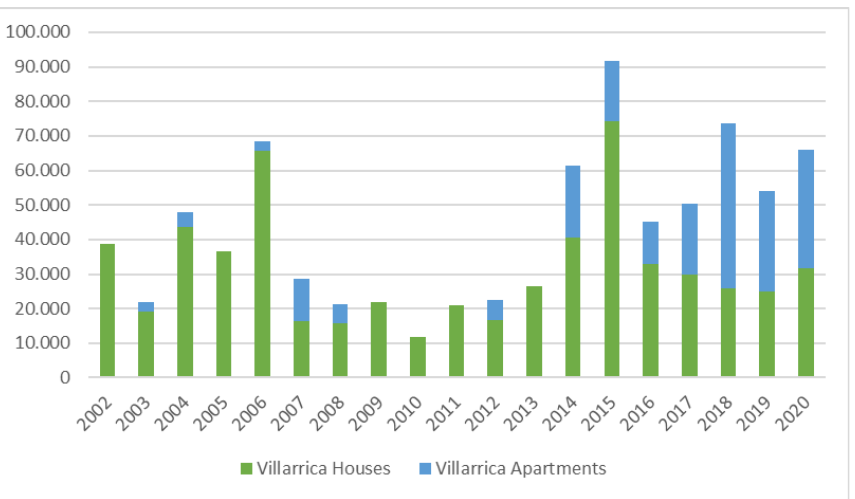
Figure 5. Square metres of housing built in the district of Villarrica, 2017 – 2021. Source: compiled by the authors using data from the Urban Observatory, Ministry of Housing and Urban Development.